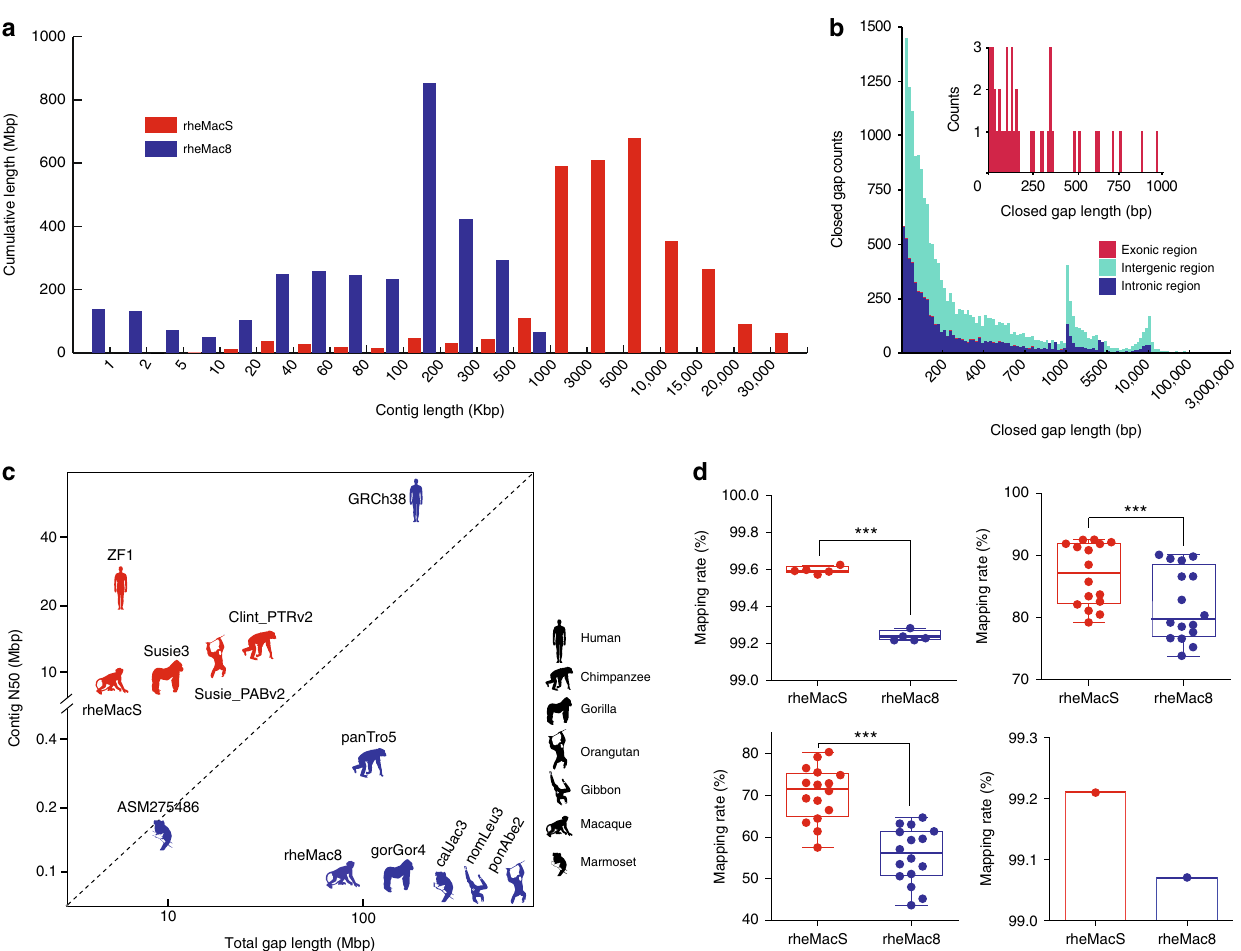
Fig. 2 Quality assessment of the Chinese rhesus macaque genome assembly. a Comparison of sequence contig length distribution between rheMacS and rheMac8. b Length distribution of the closed gaps in rheMac8. c Comparison of assembly quality among various reported primate genome assemblies. Genomes assembled with long PacBio long reads (red) are compared against those assembled using Illumina short-read and Sanger sequencing data (blue). d Comparison of mapping rates when short-read NGS data (upper left), RNA-seq data (by Hisat2: upper right; by Bowtie2: lower left), and Iso-Seq data (lower right) are mapped to rheMacS and rheMac8, respectively. Two-tailed paired t test was used for statistical assessment. *** P < 0.001. The boxplot shows the mean value (central line), upper and lower quartiles (bounds of box) and min/max values